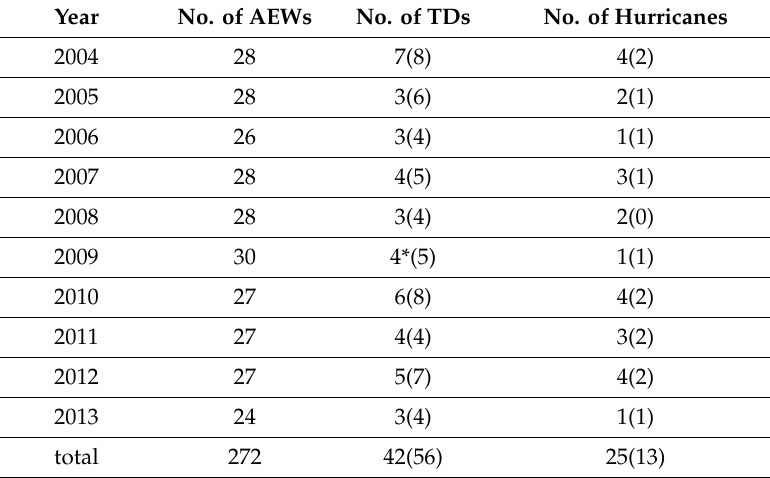
Figure 8. The feature of a collection of band-pass filters within the EMD/EEMD/PEEMD. Panels display the spectra of the first nine intrinsic mode functions (IMFs) that were obtained from the decomposition of Gaussian white noise with one million points. The horizontal represents the logarithm of the frequency (courtesy of [15]).